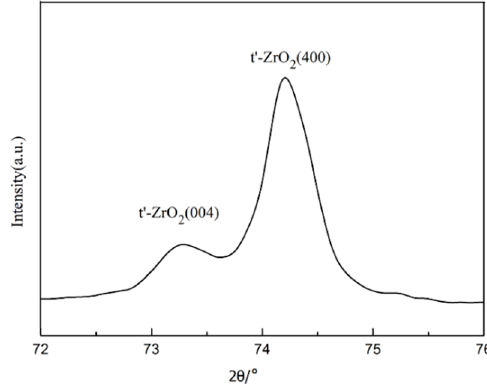
Figure 8. XRD patterns of the as-sprayed coating with 2 θ between 72 ◦ and 76 ◦ .